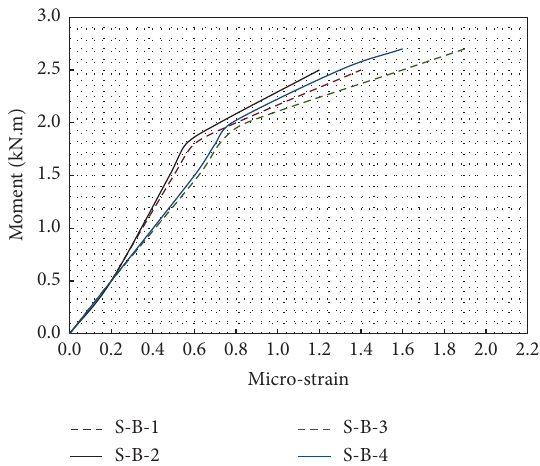
Figure 6: Load-deflection of group A beams.